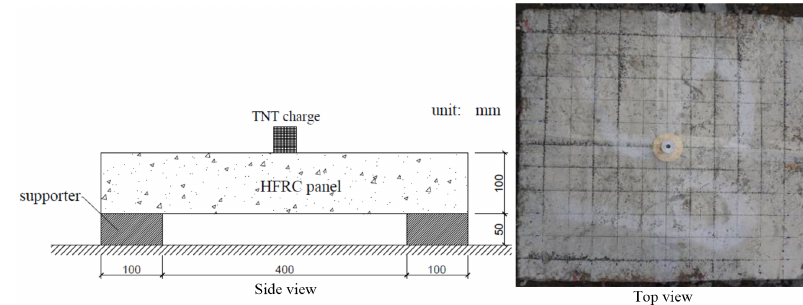
Figure 5. Detonation test